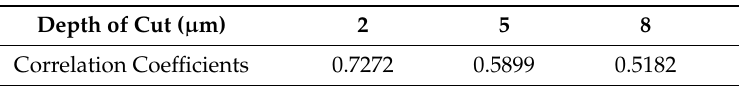
Table 3. The correlation coefficients between the P-V value of thrust force and dimensional error of machined grooves with spindle speed under different depth of cut.